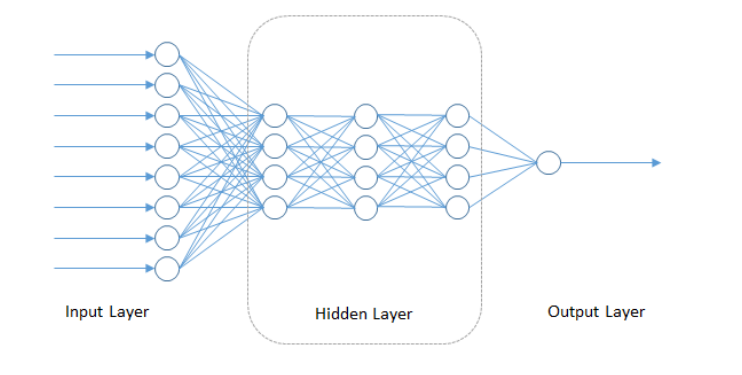
Figure 4. Structure of deep neural